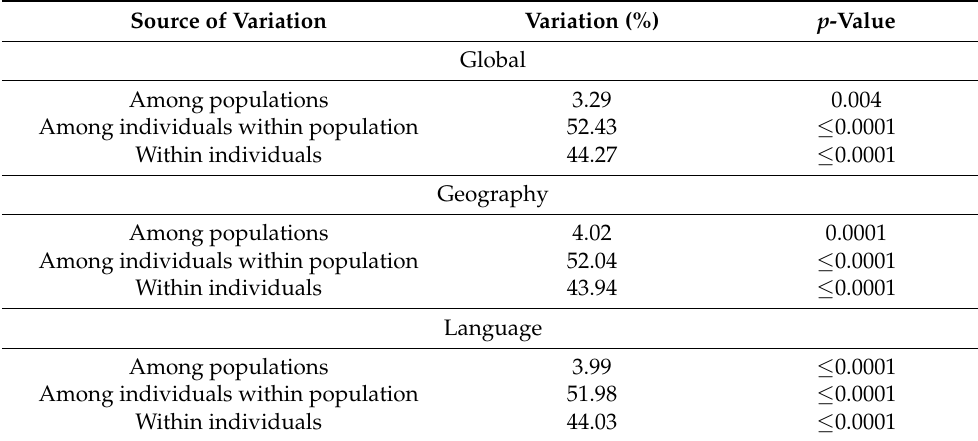
Table 1. Genotyping data from five different SCA loci of contemporary Mexican Native American populations subjected to the analysis of molecular